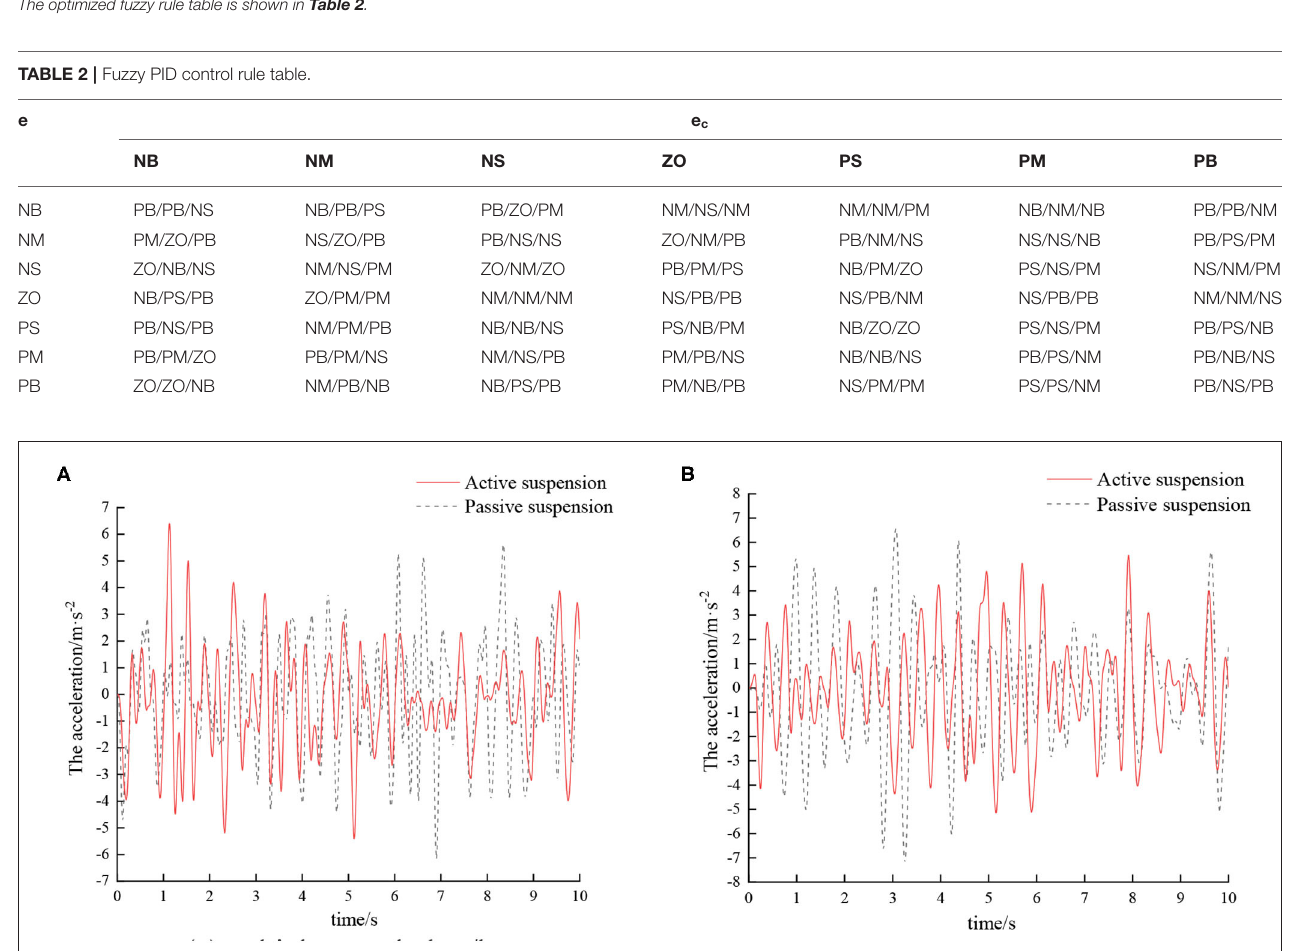
FIGURE 6 | Time domain response curve of sprayers at different speeds on D-grade roads. (A) Vehicle speed 5km/h. (B) Vehicle speed 8km/h.